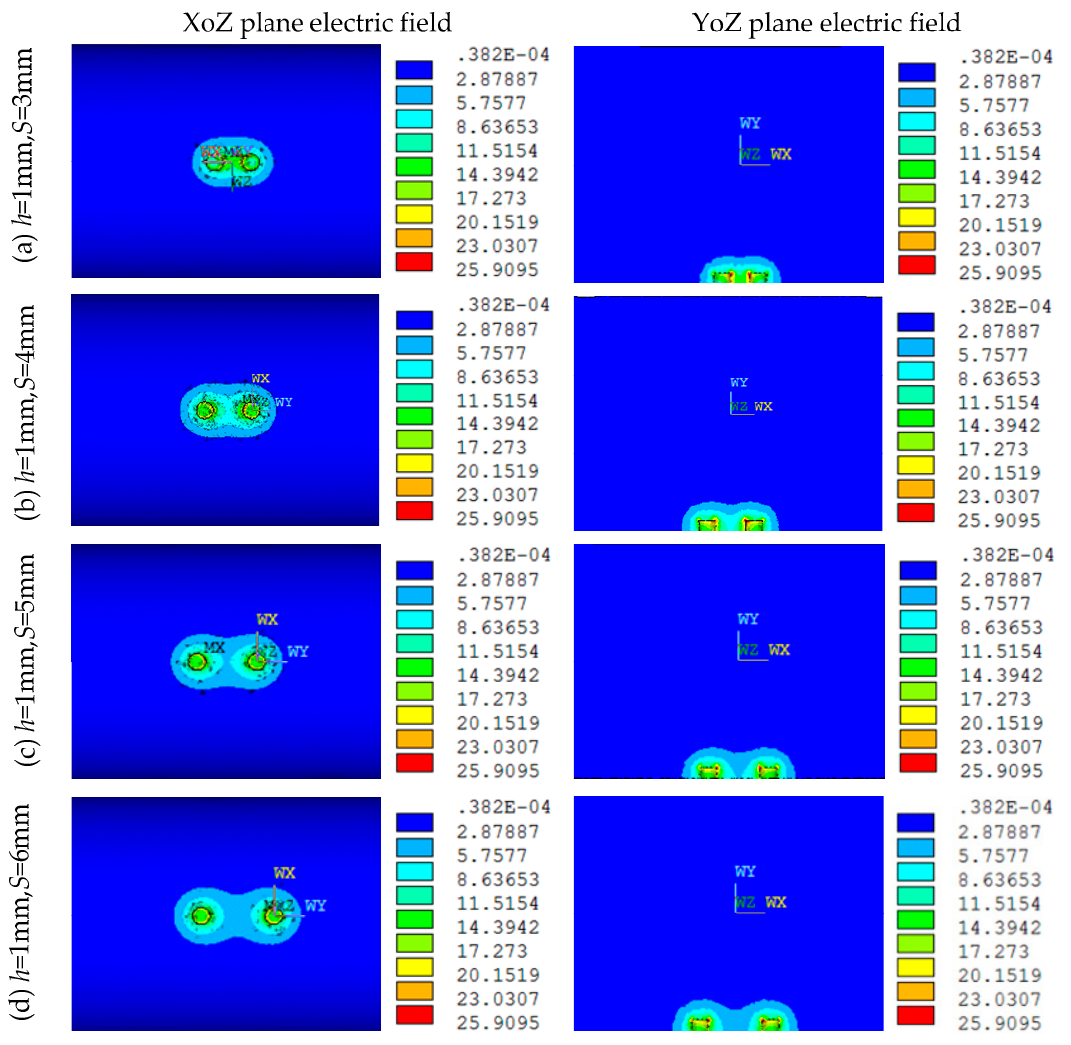
Figure 9. Electric field distribution under different S ( D = 20 mm, h = 1 mm, d = 1.5 mm): ( a ) S = 3 mm; ( b ) S = 4 mm; ( c ) S = 5 mm; ( d ) S = 6 mm.